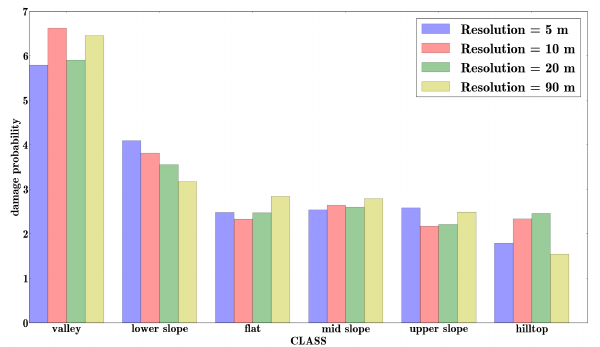
Figure 9: Percentage of affected households per class